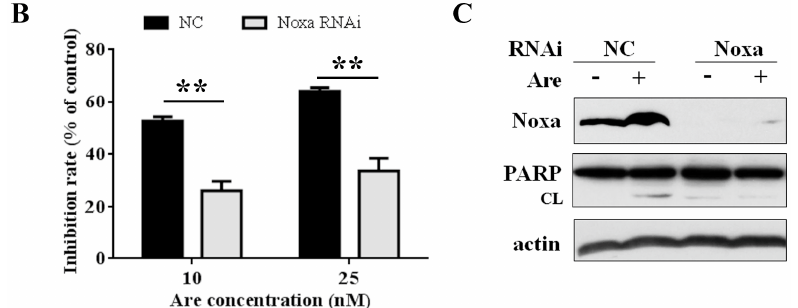
Figure 4. Noxa plays a critical role in the arenobufagin-induced inhibitory effect. ( A ) A549 cells transfected with control, or Noxa-specific siRNAs, for 48h were treated with or without arenobufagin (20 nM) for 24 h, lysed, and Western blot analysis was performed; ( B , C ) A549 cells were transfected with siRNA and treated with arenobufagin as described in ( A ); ( B ) MTT assay was conducted to analyze the cell viability of A549 cells after Noxa siRNA transfection and the following arenobufagin treatment; ( C ) Western blot assay was used to measure the expression of Noxa and PARP. ** Indicates statistical significance ( p < 0.01).